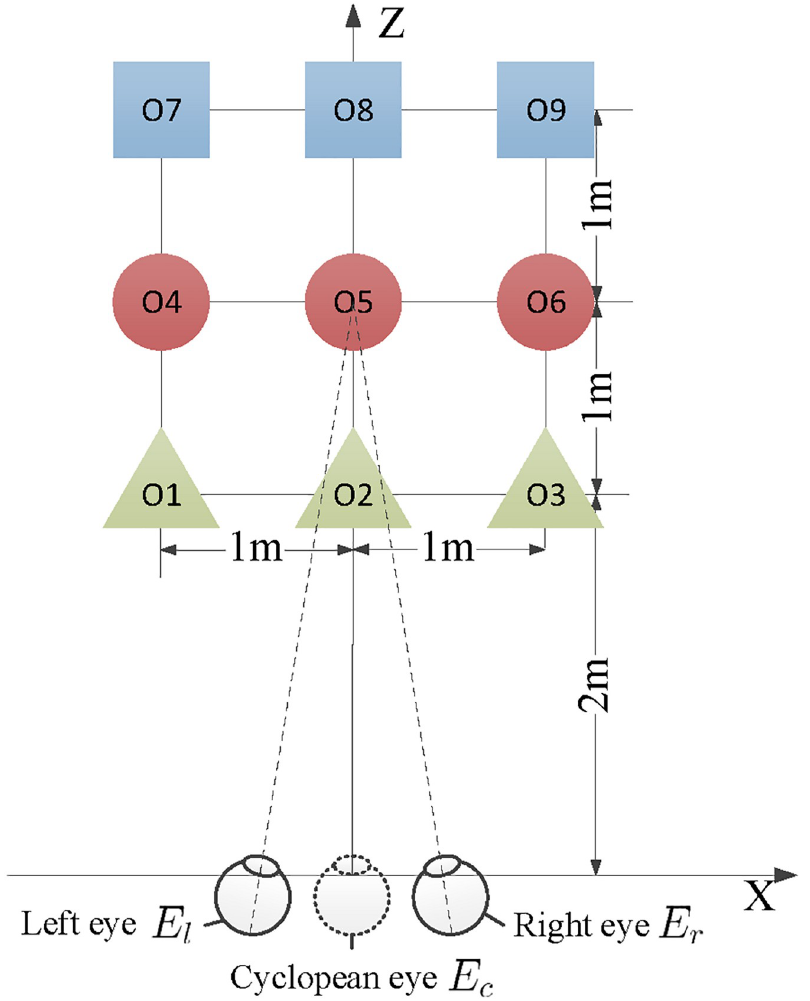
Fig 3. Sample original scene composed of 9 objects (3-blue square, 3-red circle, and 3-green triangle) for the geometric distortion analysis. Objects 1 to 9 are arranged to be on an equally 1m spaced rectilinear grid (3 × 3 in xz - plane). Figure is adapted from Hwang and Peli [3] with